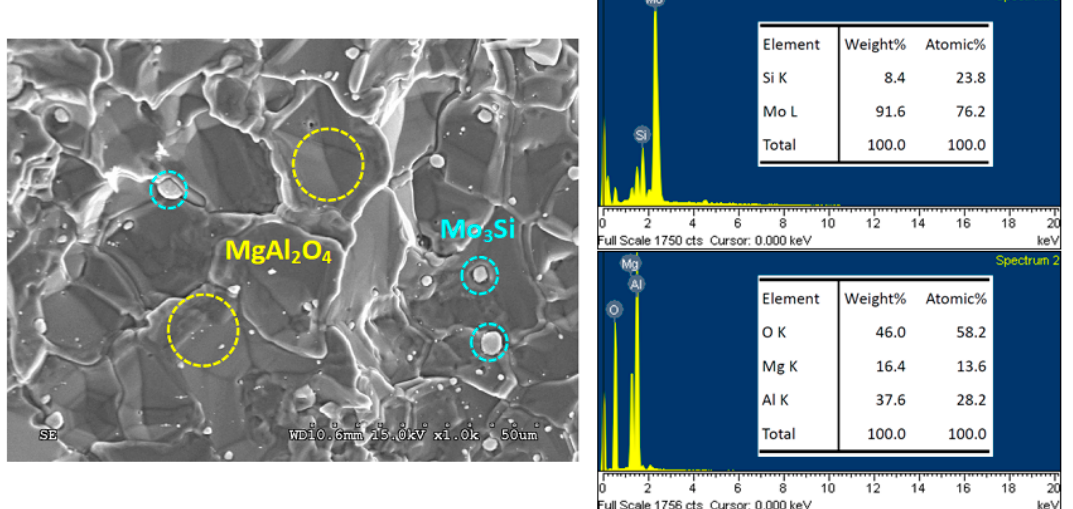
Figure 7. SEM micrograph and EDS spectra of Mo 3 Si / MgAl 2 O 4 composite obtained from Reaction (2) with y = 1.5.